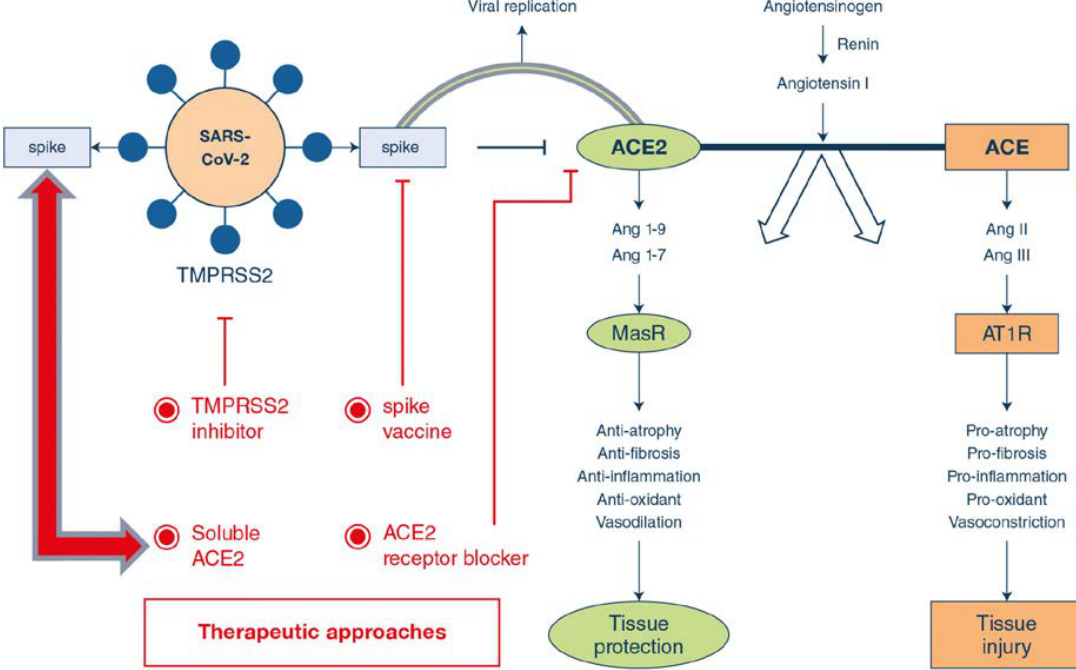
Figure 1. Pathophysiology and role of ACE2 based therapeutic mechanism of SARS-CoV-2 infection. Reprinted with permission taken by Springer [54].